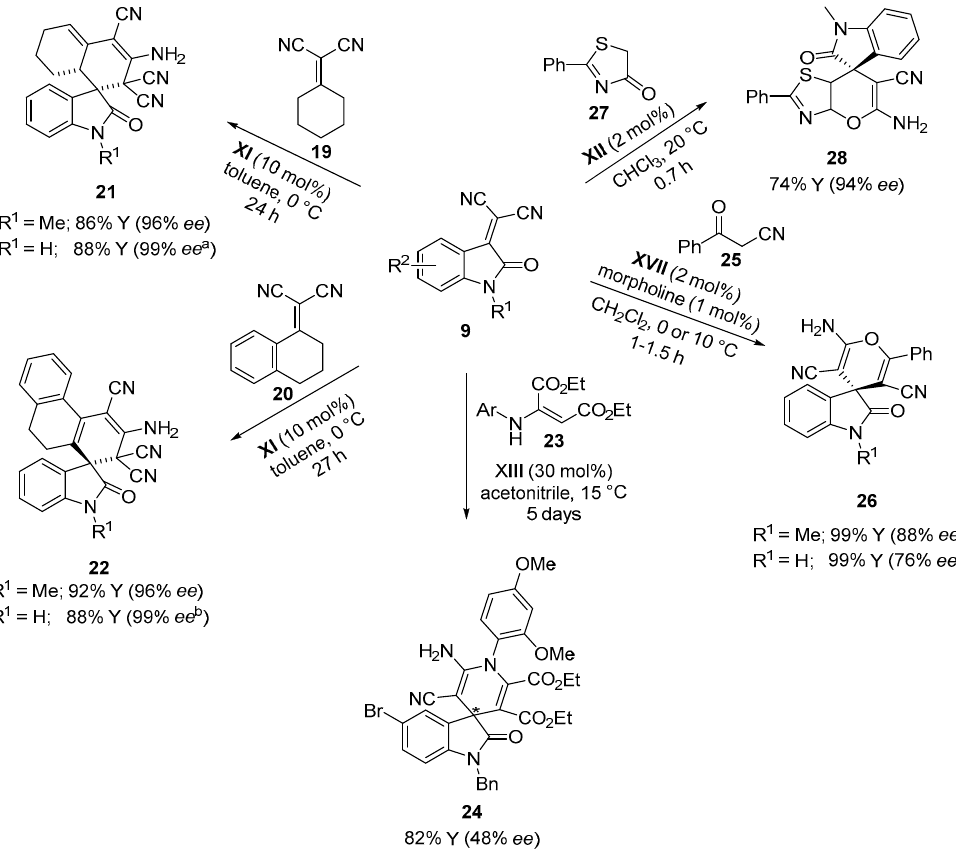
Scheme 6. Recent examples of spirooxindoles synthesized from isatylidene malonitrile derivatives through cascade processes involving Michael addition/cyclization sequence. a Three-component reaction performed during 36 h. b Three-component reaction performed during 48 h.